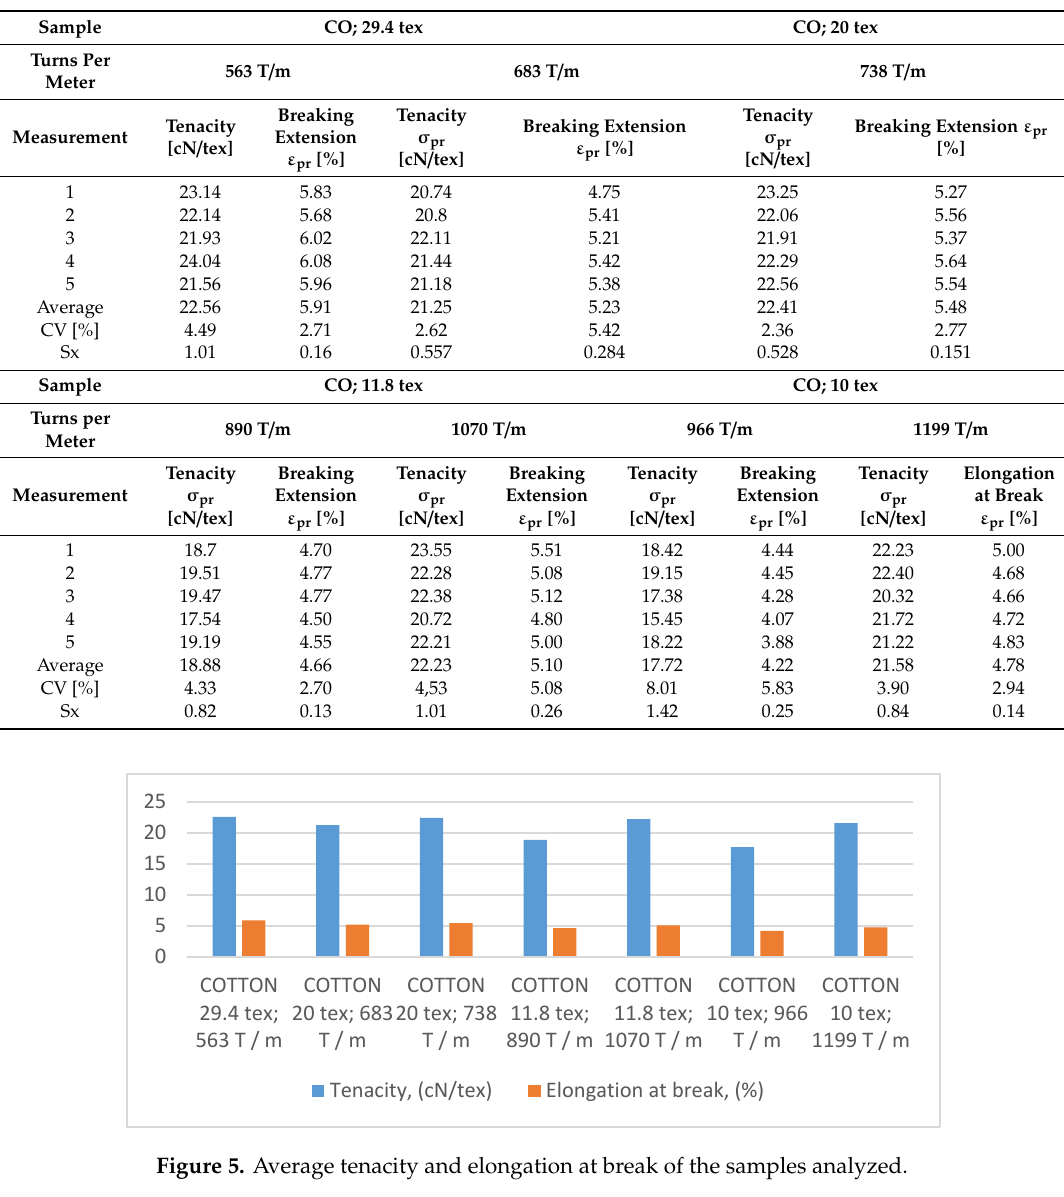
Table 7. Measured tensile properties of the yarn analyzed with di ff erent numbers of turns per meter.